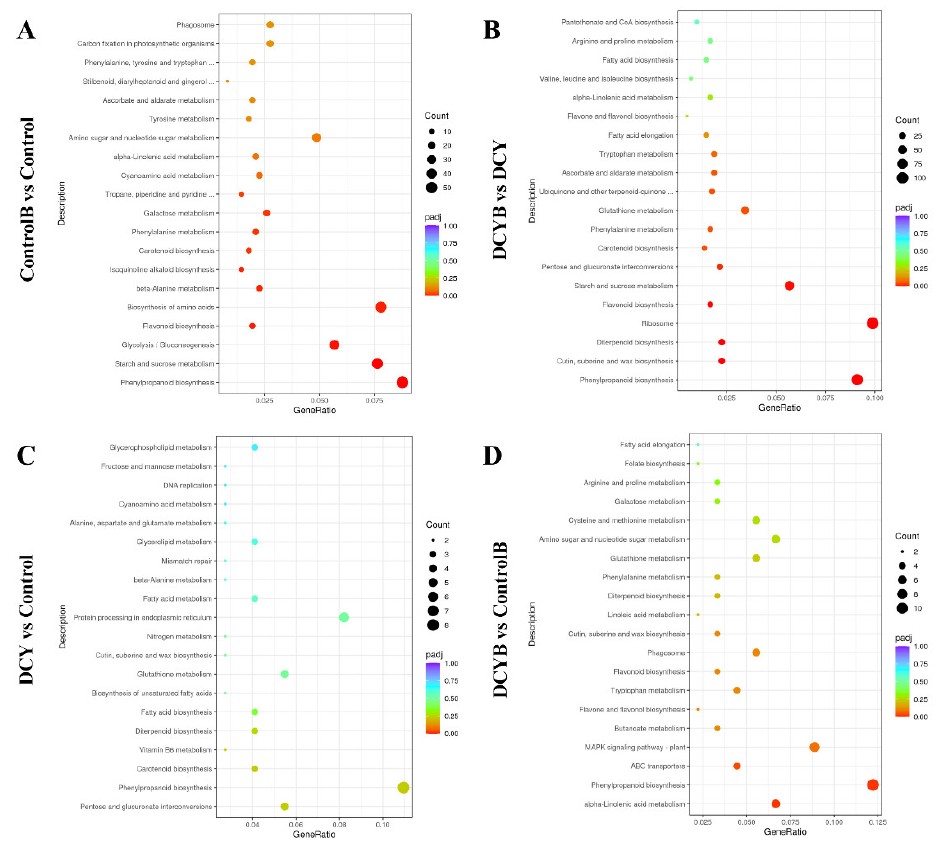
Figure 6. KEGG annotation classification chart of DEGs in different comparative groups. ( A ) ControlB vs. control: the group of DEGs between control + BPH and control rice plants; ( B ) DCYB vs. DCY: the group of DEGs between DCY + BPH and DCY rice plants. ( C ) DCY vs. control: the group of DEGs between DCY and control rice plants; ( D ) DCYB vs. controlB: The group of DEGs between DCY + BPH and control + BPH rice plants. The x -axis indicated enrichment factor, the y -axis was padj.